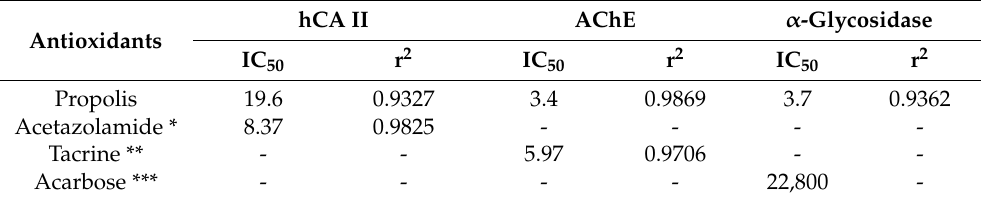
Table 5. Half-maximal inhibition concentration (IC 50 , µ g/mL) of propolis against human carbonic